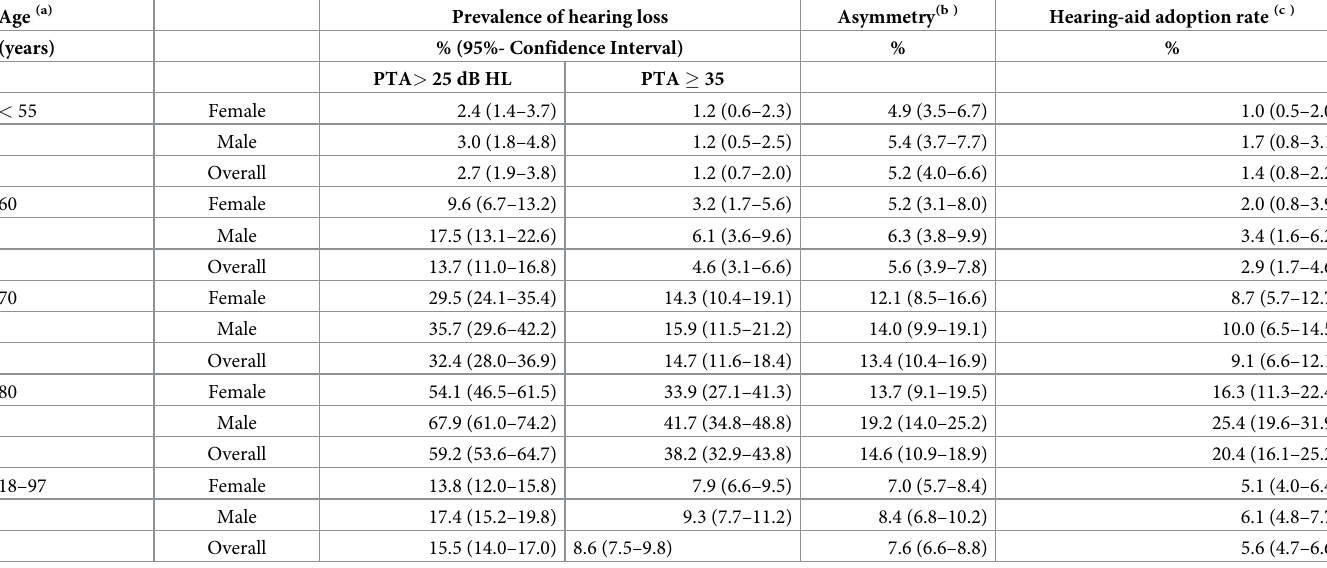
Table 2. Prevalence of hearing loss based on the PTA in the better ear, HTL asymmetry, and hearing-aid